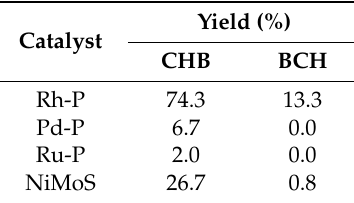
Table 1. Product yields in the hydrogenation of BP over NM-P and NiMoS catalysts at 270 ◦ C. CHB: cyclohexylbenzene, BCH: bicyclohexyl.